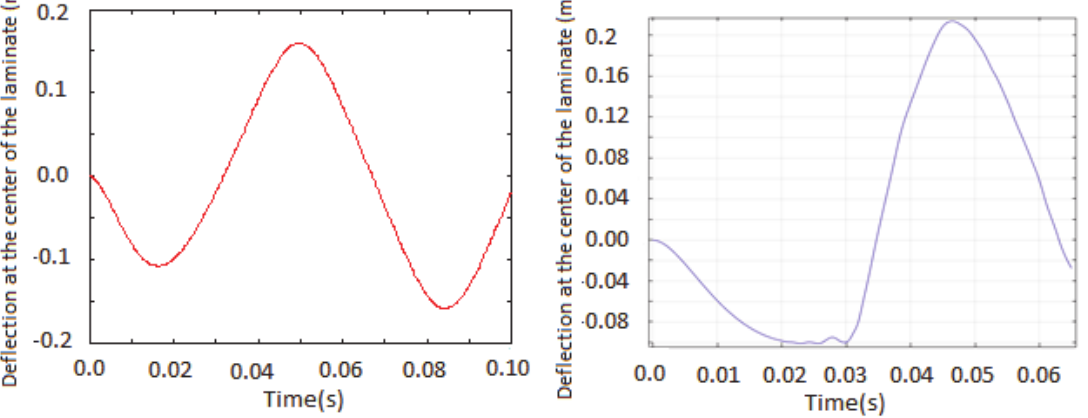
Fig. 9: Calculation of the membrane deformation resolving SDOF system equation or using FEA model with a single ply.